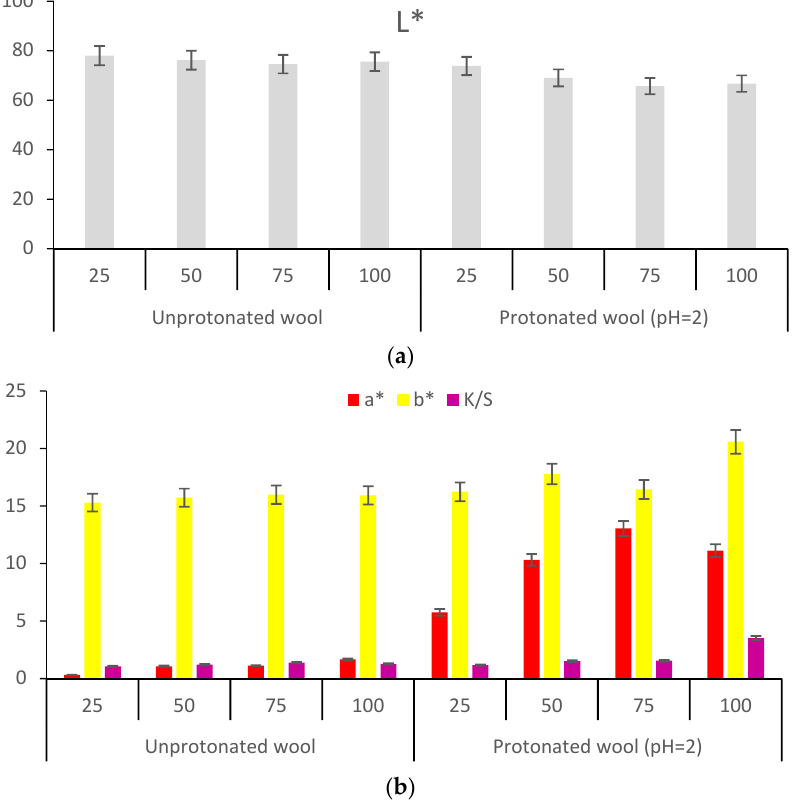
Figure 13. Influence of increasing the volume of colored extract on the color characteristics of wool samples dyed without protonation and with protonation at pH = 2: L* ( a ) and a*, b*, K/S ( b ); dyeing conditions: T = 40 °C, t = 2 h, M = 1:100.